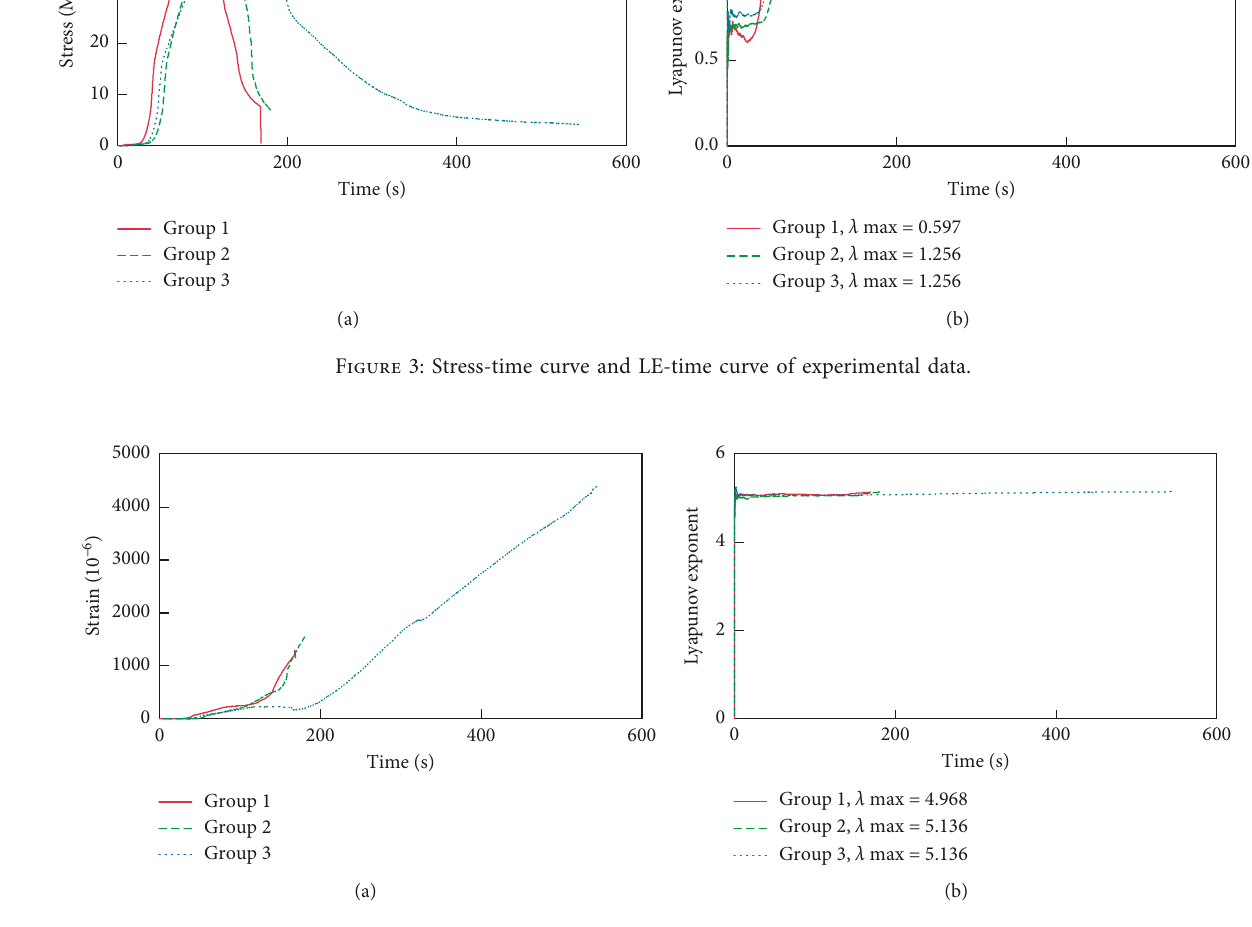
Figure 4: Strain-time curve and LE-time curve of experimental data.